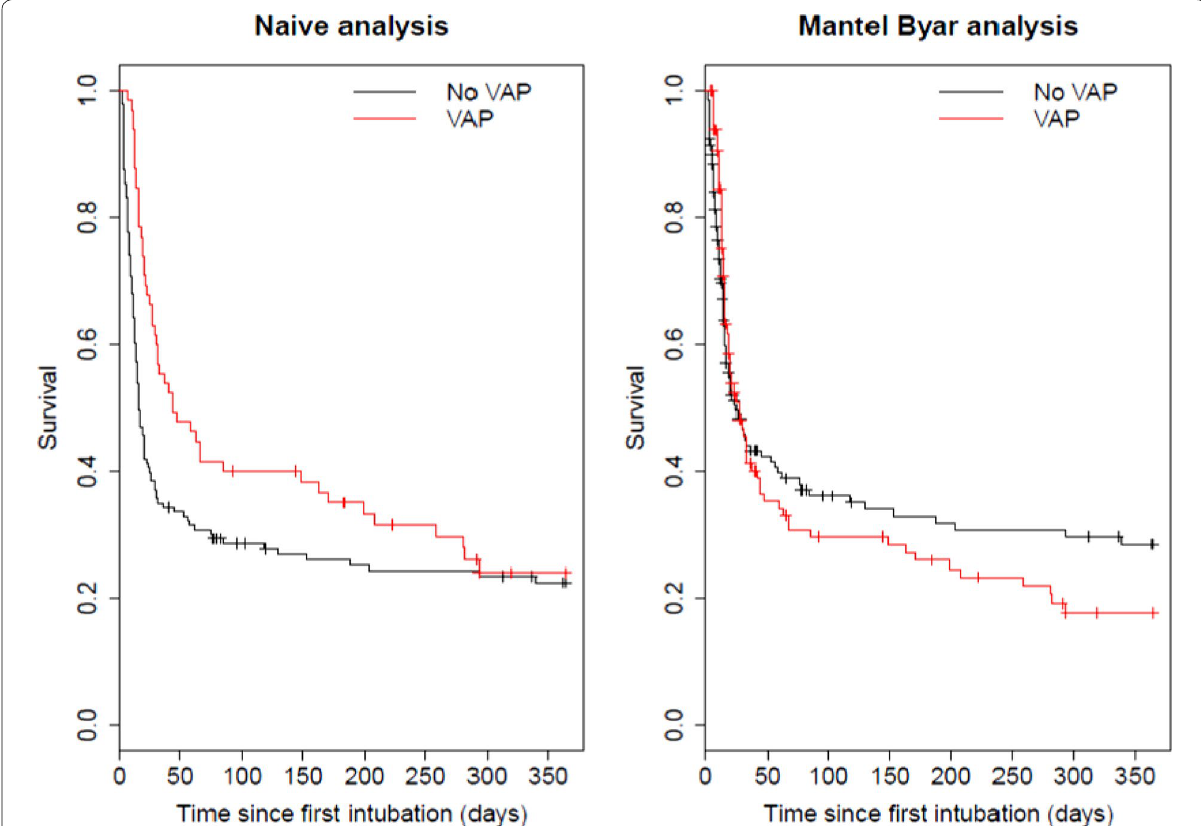
Fig. 3 One‑year survival according to ventilator‑associated pneumonia status: naive analysis and time‑dependent Mantel–Byar